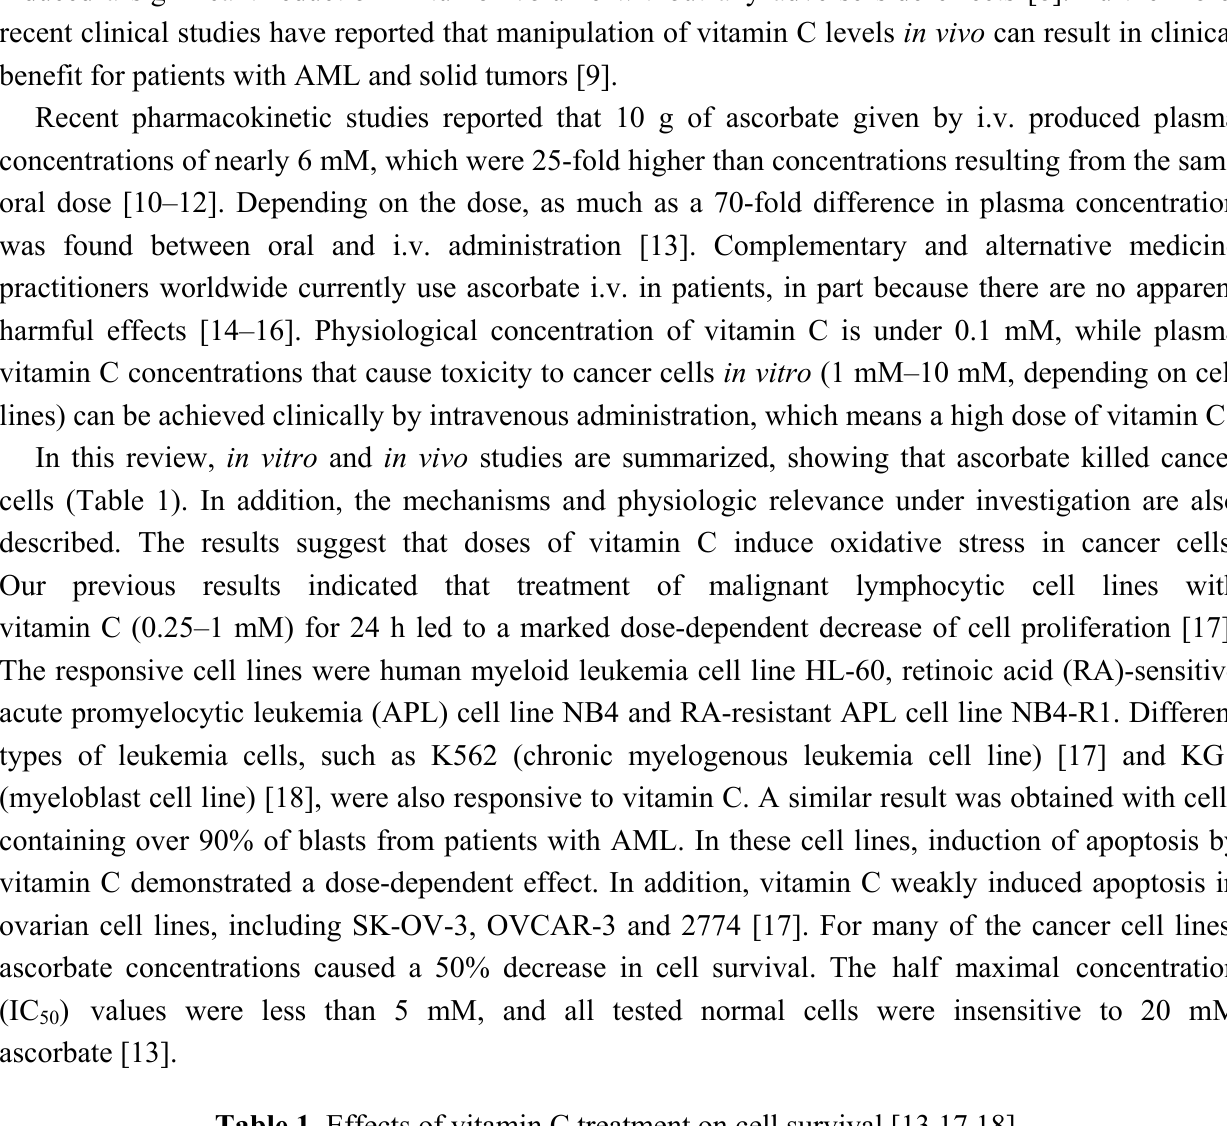
Table 1. Effects of vitamin C treatment on cell survival